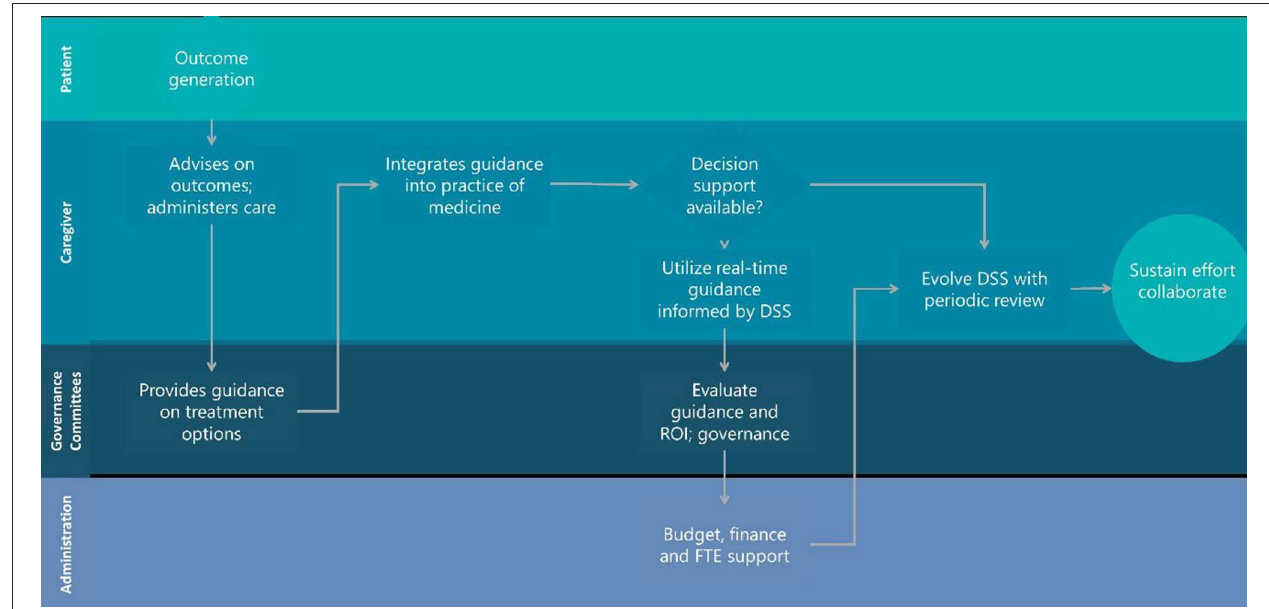
FIGURE 1 | Hospital landscape for sustainable decision support engagement that evolves with the practice of medicine during habitual